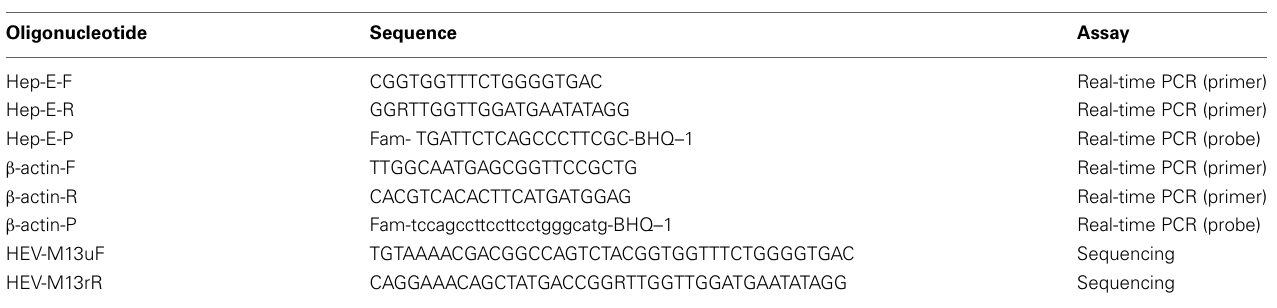
Table 1 | Primers and